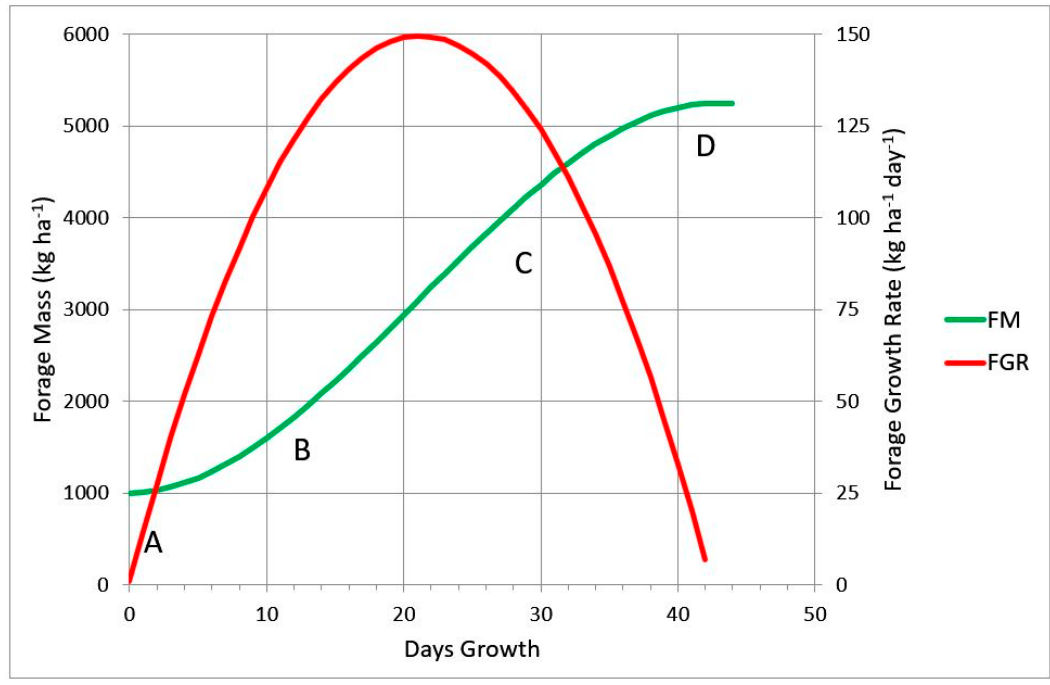
Figure 1. Pasture growth based on a third order (cubic) regression of forage mass (FM, kg DM ha − 1 ) vs. time (days), starting with the residual FM (RFM) remaining at the end of the previous grazing event (FM = RFM + b Day + c Day 2 − d Day 3 ) and the associated forage growth rate (FGR, DM ha − 1 day − 1 ) based on the first derivative of the cubic regression (FGR = b + 2 c Day − 3 d Day 2 ), where RFM is 1000, b is 1, c is 7 and d is 0.11.